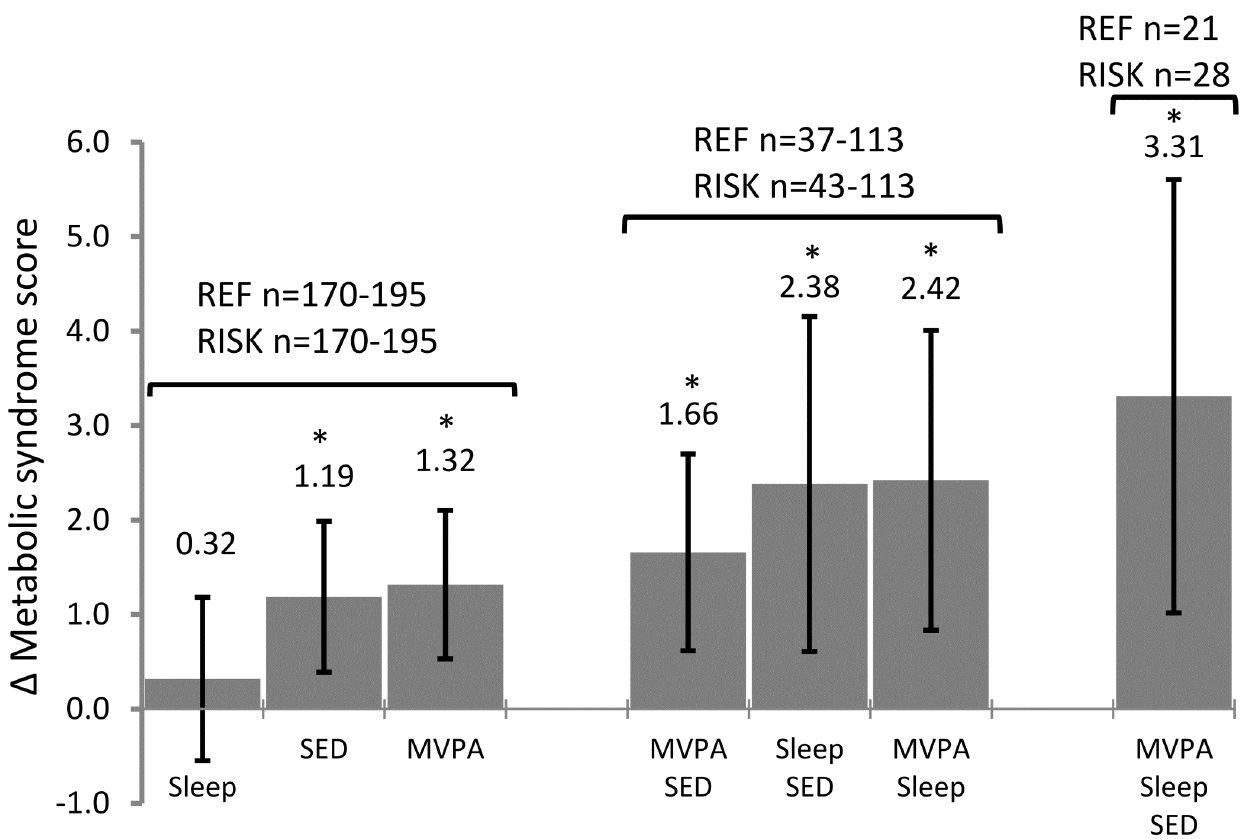
Figure 1. Combined associations between changes in movement behaviors and changes in the metabolic syndrome (MetS) score 1 over a 200-day follow-up period in Danish children. Change in movement behaviors between baseline and day 200 was divided into tertiles using the 1 st and 3 rd tertile as a reference group (REF) and a risk group (RISK). Data are presented as unstandardized regression coefficients ( b ) with 95% confidence intervals (CI) between reference group and risk group using a linear mixed model. Sleep, sleep duration (RISK ,2 24.8 vs. REF .2 5.5 min/night); SED, sedentary time (RISK . 1.6 vs. REF ,2 3.4%); MVPA, moderate-to-vigorous physical activity (RISK , 0.3 vs. REF . 15.2 min/day). Adjusted for days of follow up 1 MetS-score=(age, sex, pubertal status and sex-pubertal status interaction standardised z-scores of) waist circumference + MAP + HOMA IR + triglycerides – HDL-C. *P=0.001 to 0.009.